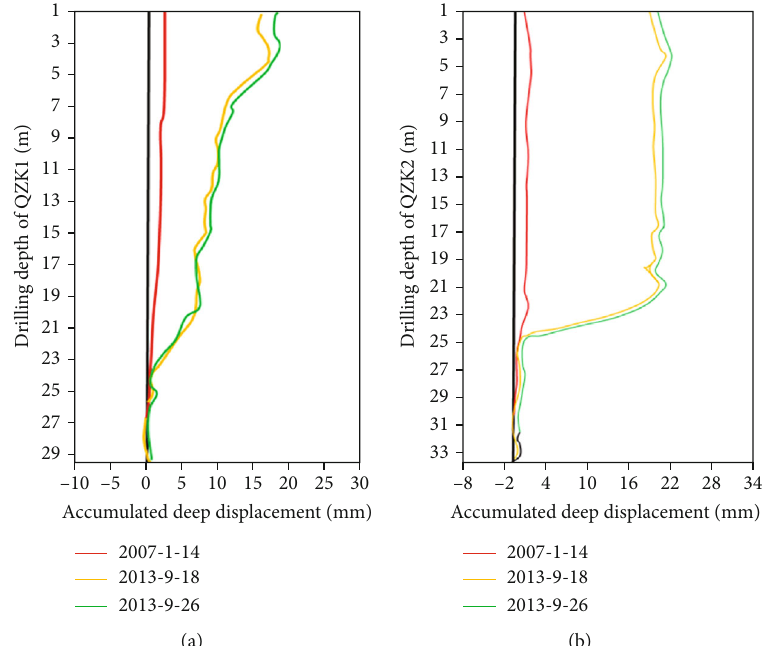
Figure 3: (a) Deep accumulated displacement monitoring curves of QZK1. (b) Deep accumulated displacement monitoring curves of